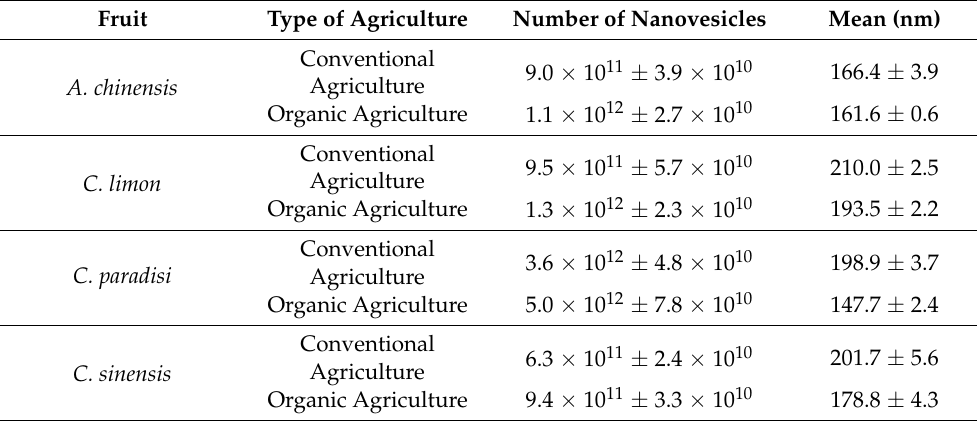
Table 1. Characterization of nanovesicles isolated from organic agriculture-derived and conventional agriculture-derived fruits.